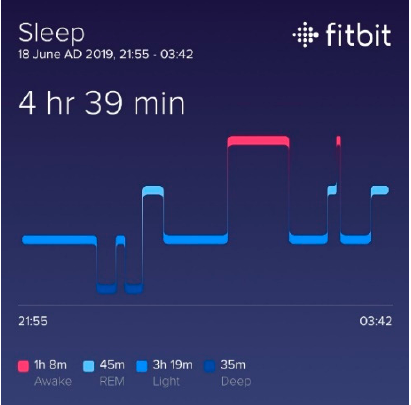
Figure A2. ZURICH, SWITZERLAND.